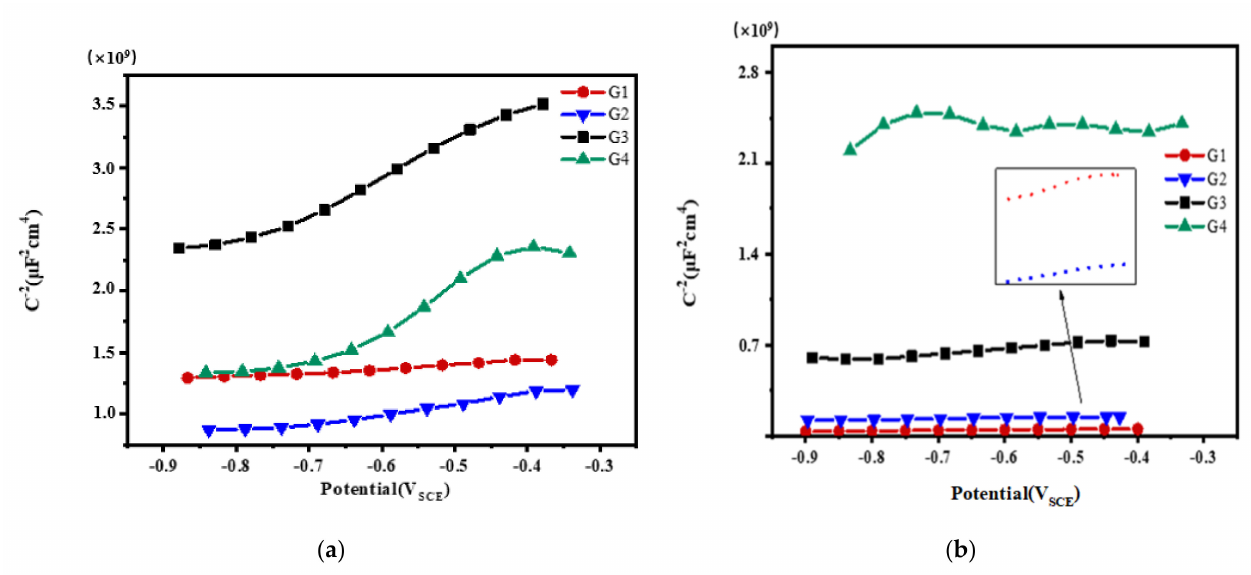
Figure 13. Each coating’s Mott–Schottky pattern for immersion for 30 days: ( a ) 20% Seawater; ( b ) 40% Seawater; ( c ) 60% Seawater.